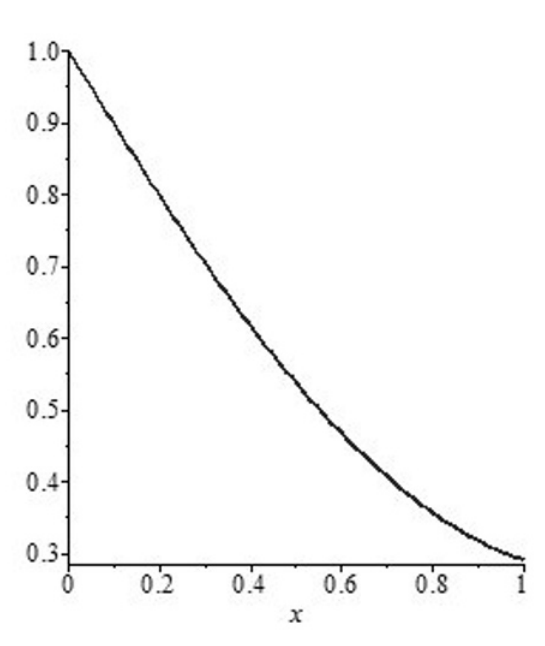
Table 1. Initial slopes B